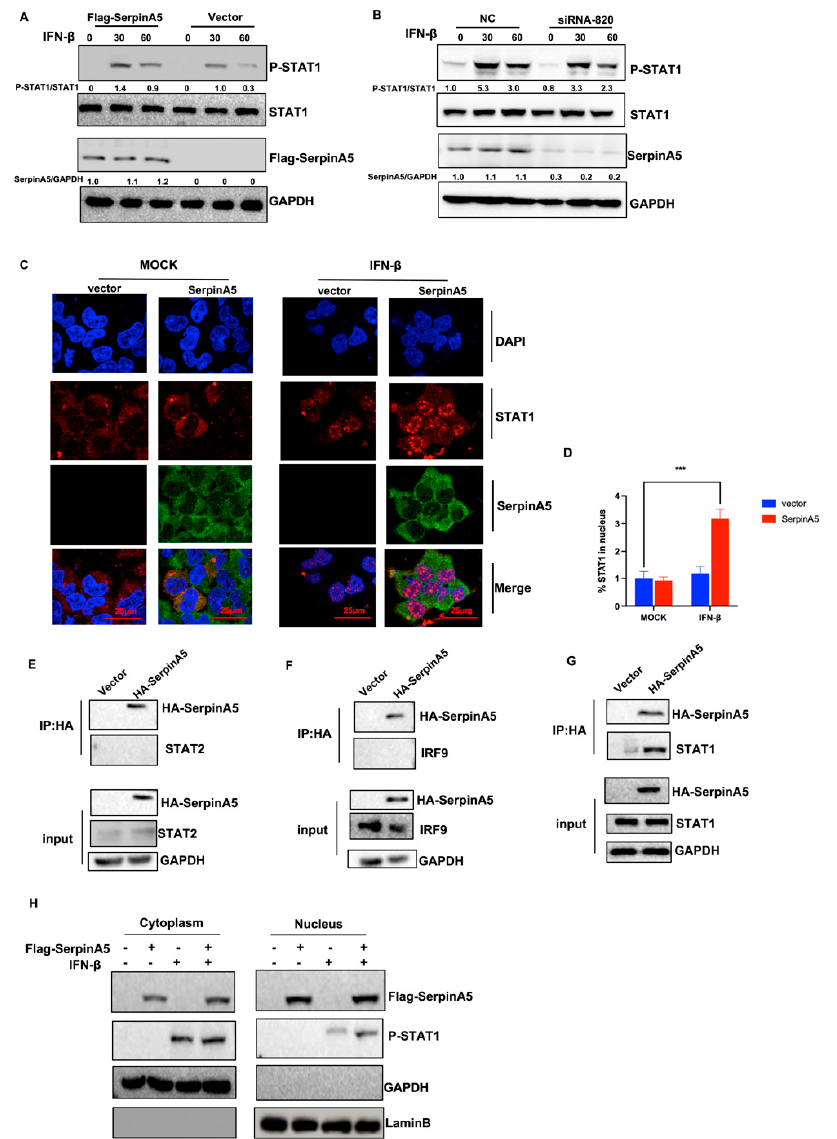
Figure 4. SerpinA5 promoted STAT1 phosphorylation and nuclear translocation. ( A ) Western blotting analysis of the expression level of STAT1 and phosphorylated STAT1 (P-STAT1) in vector or SerpinA5 transfected A549 cells with IFN- β stimulation (100 ng/mL). ( B ) Western blotting analysis of the expression level of STAT1and P-STAT1 in negative control (NC) or SerpinA5-knockdown THP-1 cells with IFN- β stimulation (100 ng/mL). ( C ) HEK-293T cells were transfected with 2 μ g of Flag–SerpinA5–expressing plasmids for 24 h. The cells were then mock-infected or stimulated by IFN- β for 30 min and subjected to confocal microscopy analysis using the anti-Flag and anti-STAT1 antibodies. The scale bar represents 25 μ m. These cells shown in visual field represent three independent experiments. ( D ) Quantification of the percentage of STAT1 in the transfected vector or Flag–SerpinA5–expressing plasmids cells in the nucleus with or without IFN- β treatment. ( E – G ) HEK293T cells were transfected with HA-SerpinA5 or empty vector and 36 h later the cell lysates were collected and subjected to co-IP analysis using an anti-HA tag antibody. The whole-cell lysates and IP complexes were analyzed by Western blotting using antibodies against STAT1, STAT2, IRF9, HA, and GAPDH. ( H ) HEK293T cells were transfected with Flag-SerpinA5 or empty vector for 24 h, and then treated with IFN- β (100 ng/mL) for 6 h. The nuclear and cytoplasmic fractions were isolated and subjected to Western blot analysis with antibodies against p-STAT1 and Flag-SerpinA5. Data from at least triplicates were shown as the mean ± SD. *** p < 0.001.